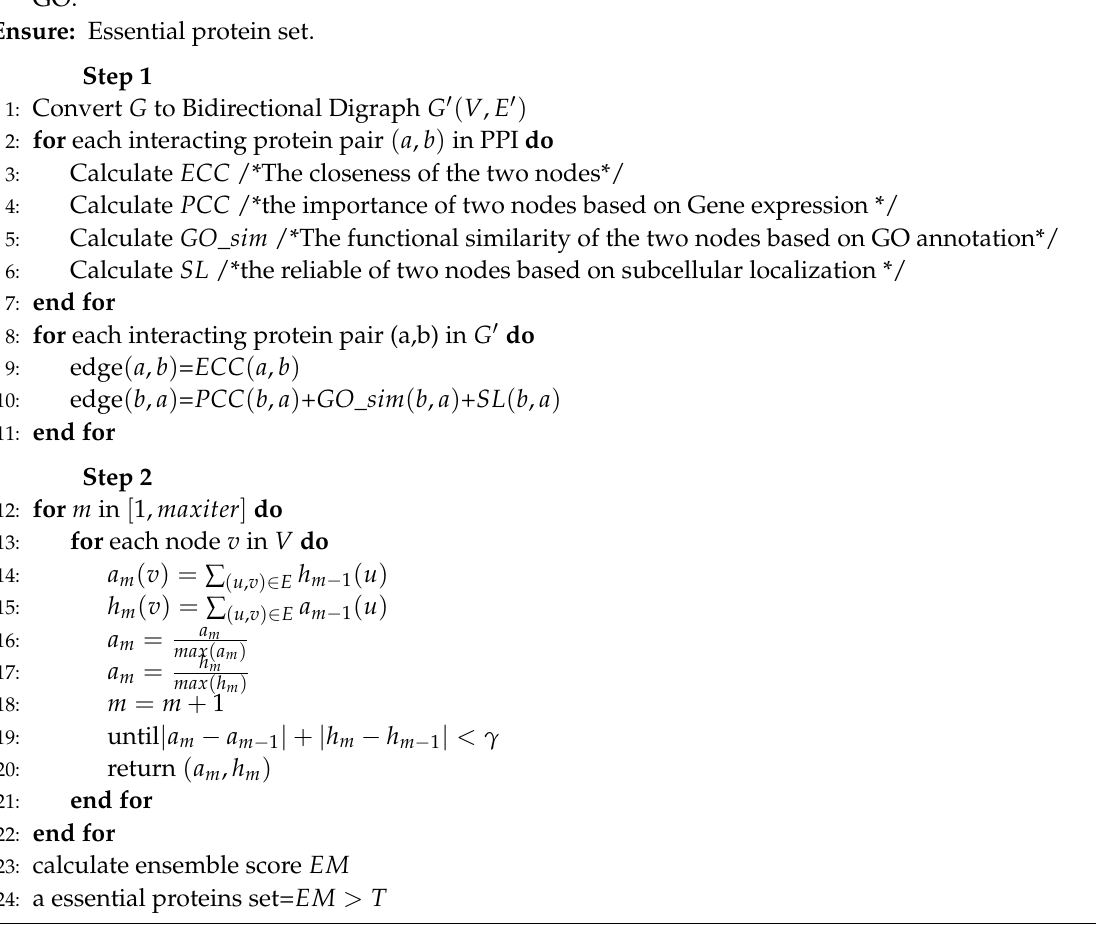
Algorithm 1 HSEP essential proteins